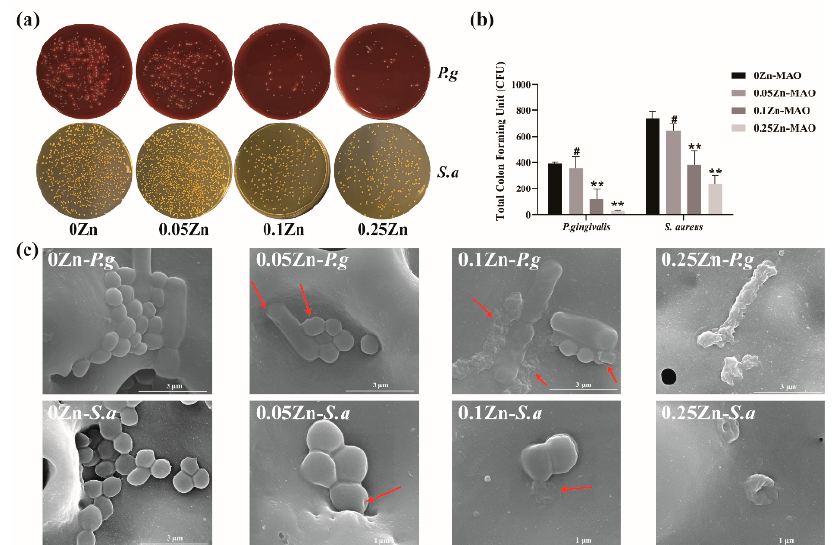
Figure 6. Antibacterial activities of Zn-doped coatings against S. aureus and P. gingivalis ( a ); CFU results after S. aureus and P. gingivalis were cocultured with the Zn-MAO coating for 24 h ( b ). The SEM images ( c ) of S. aureus and P. gingivalis cultured on different surface after 24 h of incubation. Data are presented as mean ± SD; (** p < 0.01, # p > 0.05, vs. 0Zn-MAO group).